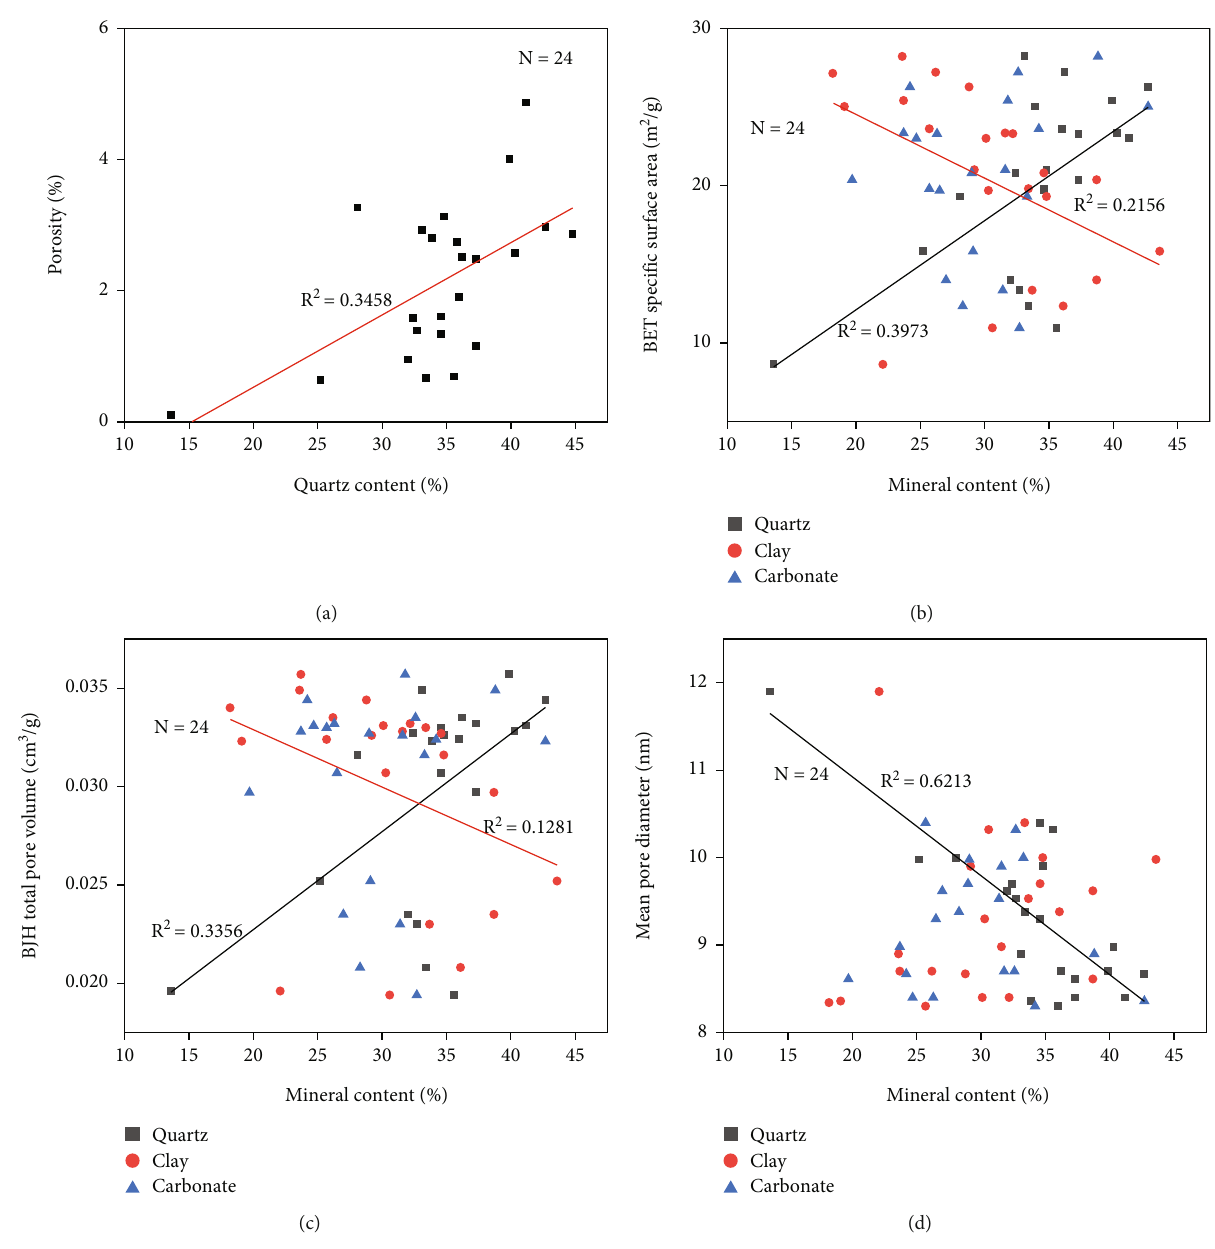
Figure 18: Relationships between di ff erent minerals and pore